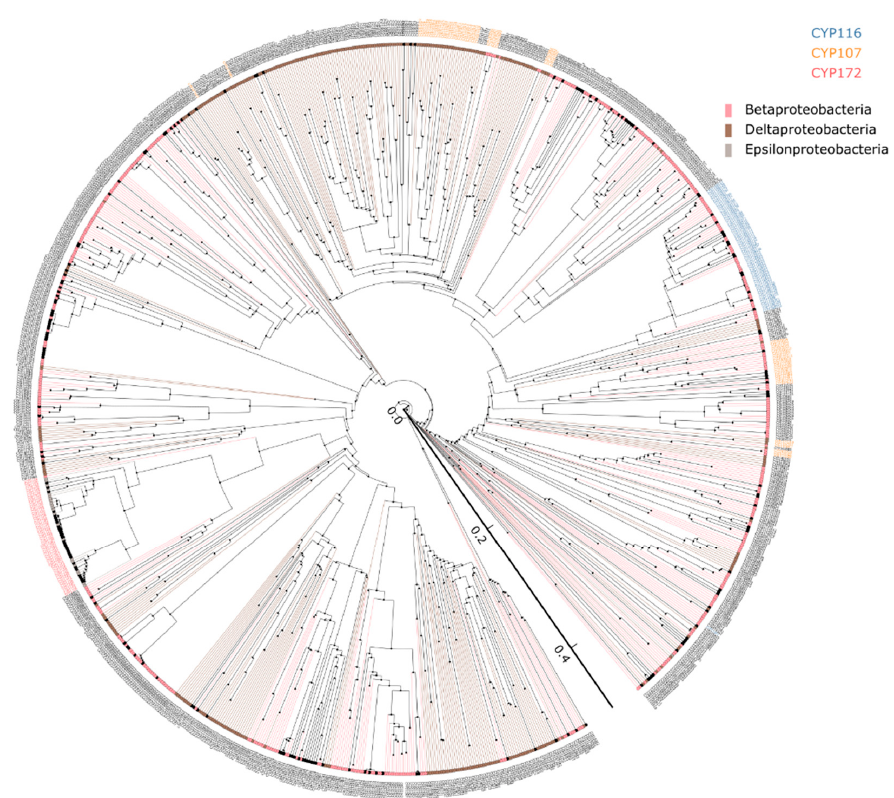
Figure 1. Phylogenetic analysis of P450s from gamma-, delta-, and epsilon-proteobacterial species. P450 families that are expanded in these species and proteobacterial classes were highlighted in different colors and indicated in the figure. P450 protein sequences used for constructing the phylogenetic tree are presented in Table S3. A high-resolution phylogenetic tree is provided in Figure S1.